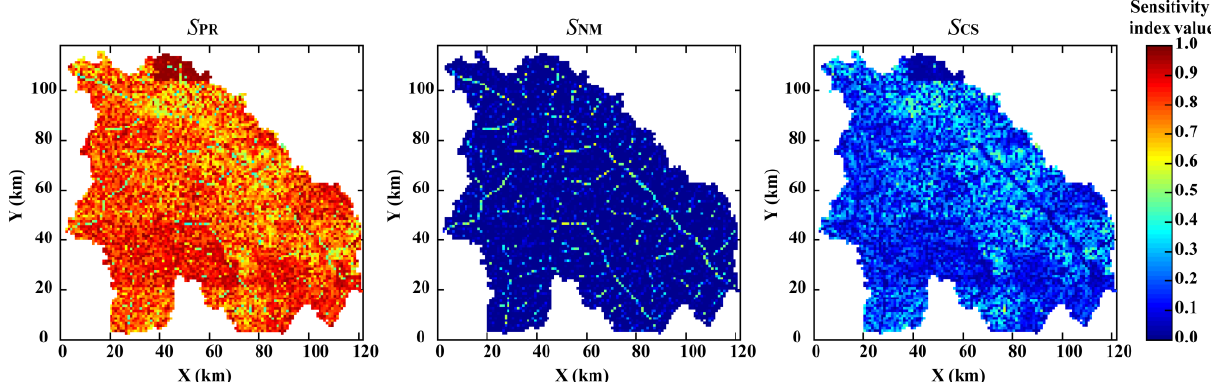
Figure 7. Maps of parametric ( S PR ), numerical model ( S NM ), and climate scenario ( S CS ) sensitivity index values for time-averaged evapo- transpiration (ET)